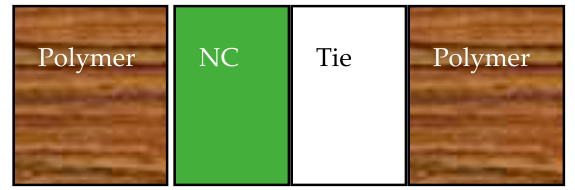
Figure 8. Multilayer structures: coating and lamination of nanocellulose.